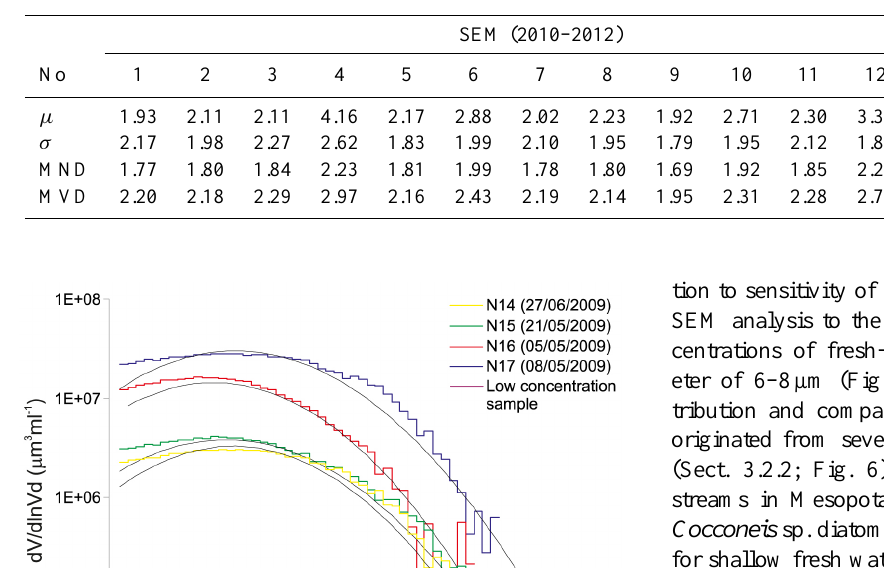
Table 1. Characteristics of frequency distributions of dust particles (µm). Samples from 2009 and 2010–2012 were analysed using CCM and SEM respectively. Modal values ( µ ) and standard deviations ( σ ) are given for the size distributions with the minimum equivalent particle diameter of 1µm. MND and MNV are mean number and mean volume diameters respectively. Events are numbered as on Fig. 2.